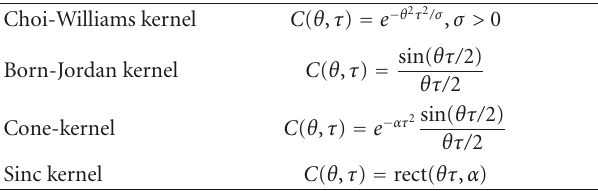
Table 1: Some of the commonly used